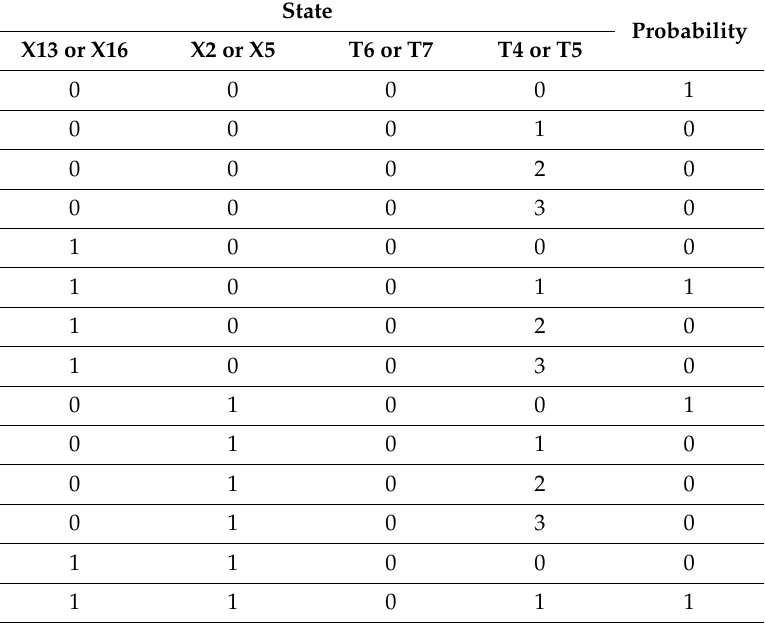
Table A3. CPT for T4 and